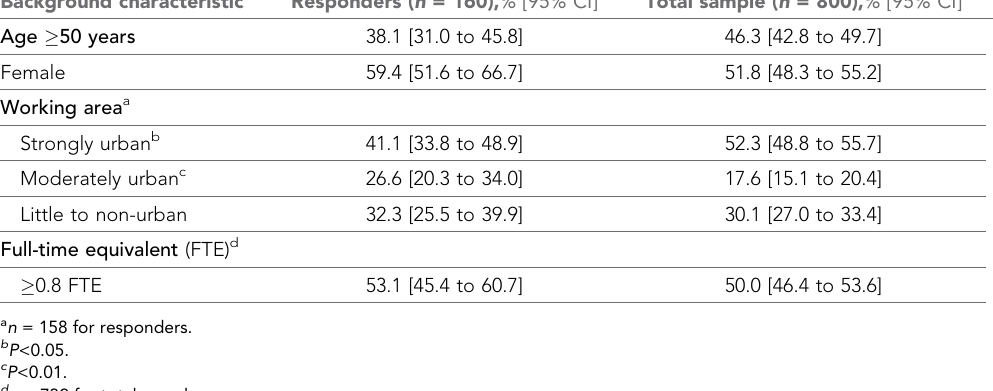
Table 1. Characteristics of the responding GPs and total sample